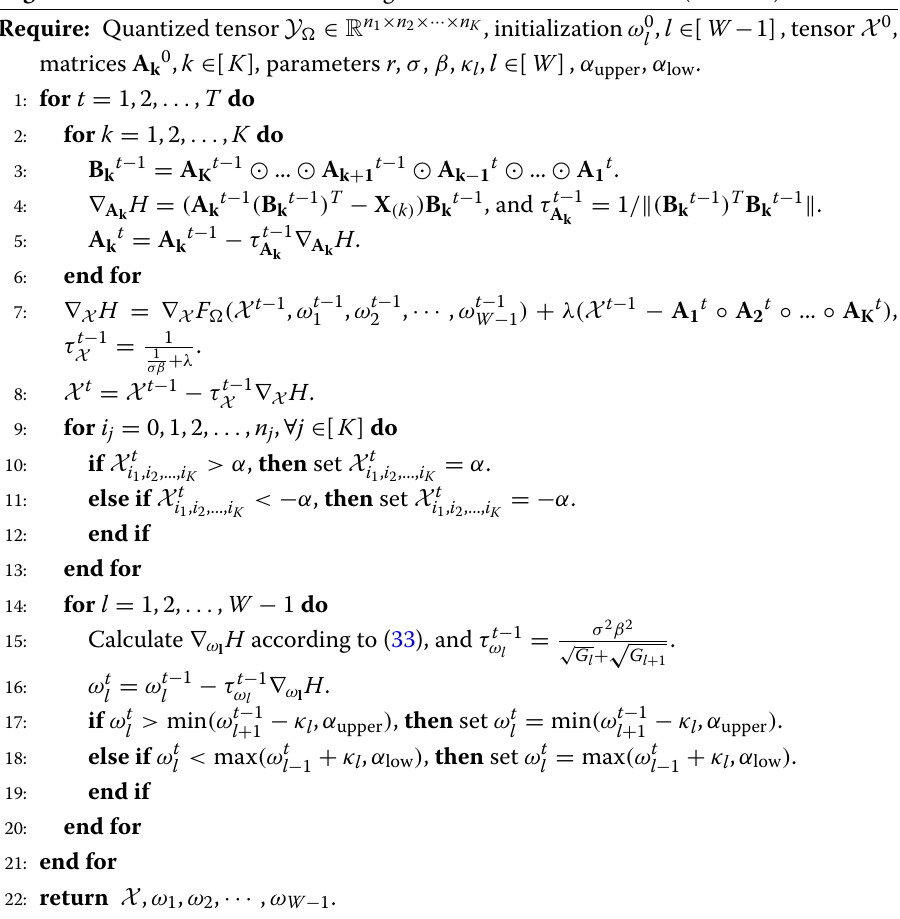
Algorithm 1 Tensor Based Alternating Proximal Gradient Descent